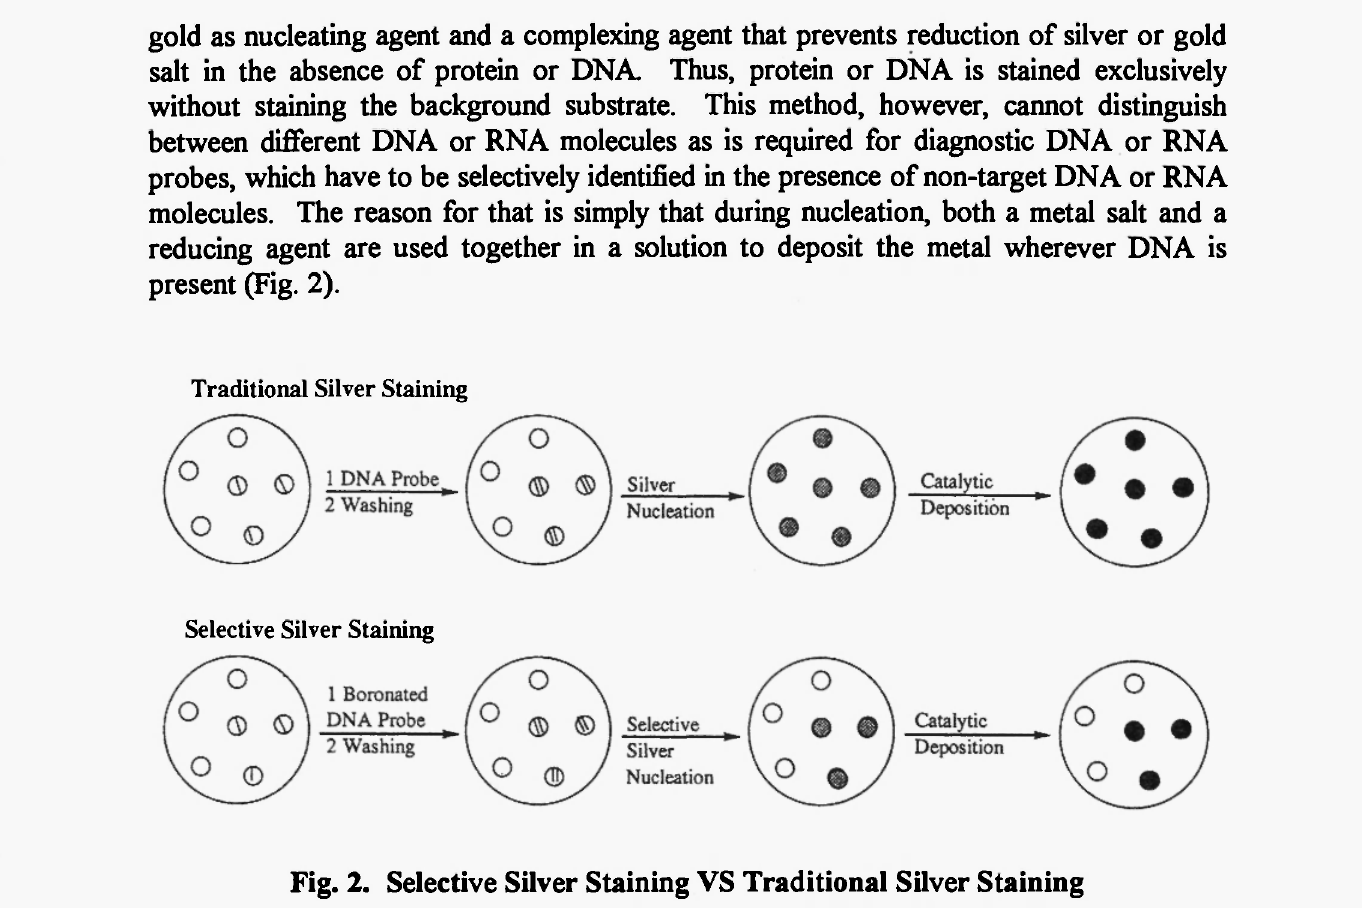
Fig. 2. Selective Silver Staining VS Traditional Silver